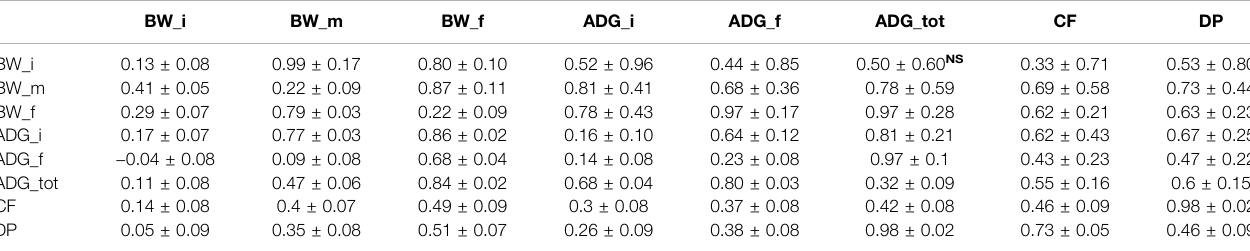
TABLE 2 | Mean of genetic (over diagonal) and phenotypic (under diagonal) correlations, and heritability (diagonal) with the respective standard deviations in target traits in Rendena population, estimated under ssGBLUP models. ( NS ) stands for non-signi fi cant correlations. BW_i BW_m BW_f